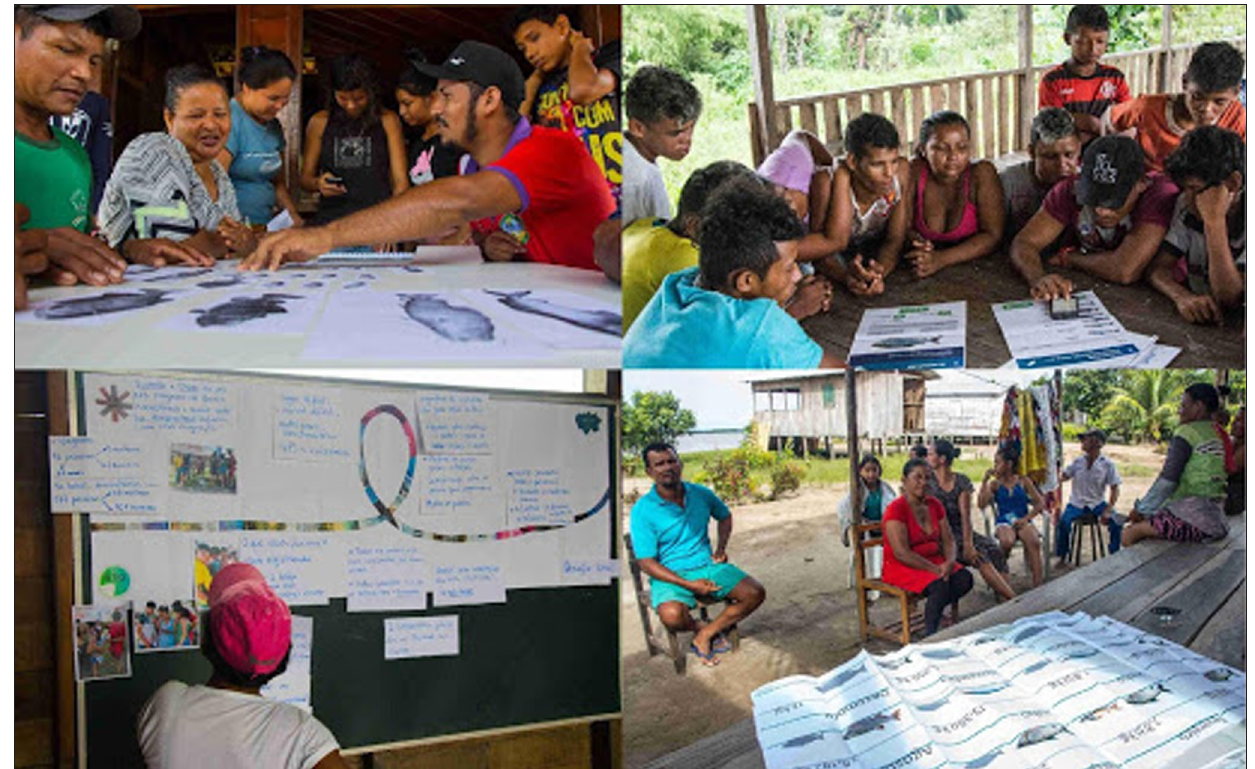
Figure 3 Activities with selected target groups. Photos: Vanessa